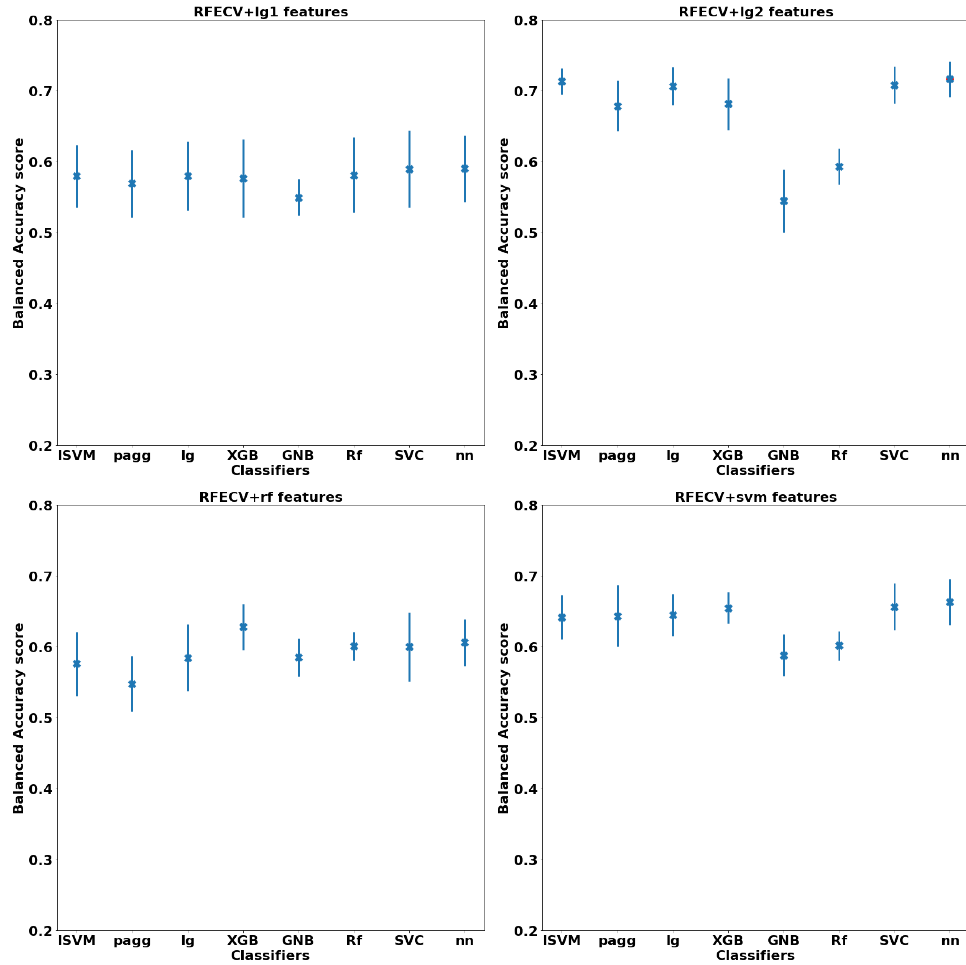
standard deviation achieved by each of the Figure 8. The highest testing balanced accuracy score ± optimized classifiers with applying RFECV with the core classifiers. The red dot labels the classifiers with the highest mean testing accuracy over the five-folds